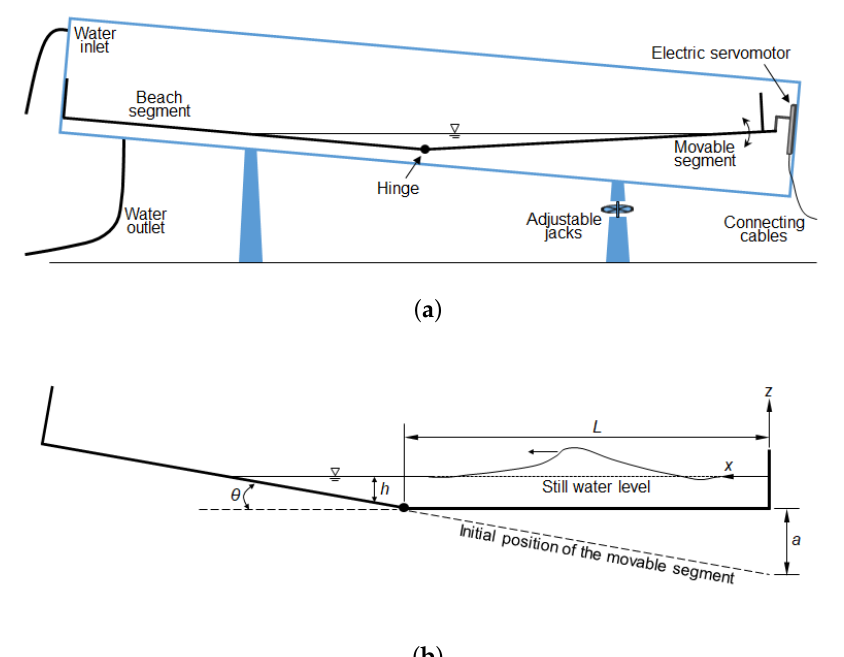
Figure 1. ( a ) Schematic of the 2 m long bottom-tilting wavemaker designed by Lu and colleagues [24,36,37]. redSee in [24] for the detailed design and configuration. ( b ) Example of a leading elevation wave generated by the movable segment with upward motion. ( x , z ) denotes the coordinate system. θ : beach slope, h : water depth, L : length of the wave generator, a : magnitude of the vertical displacement at x =